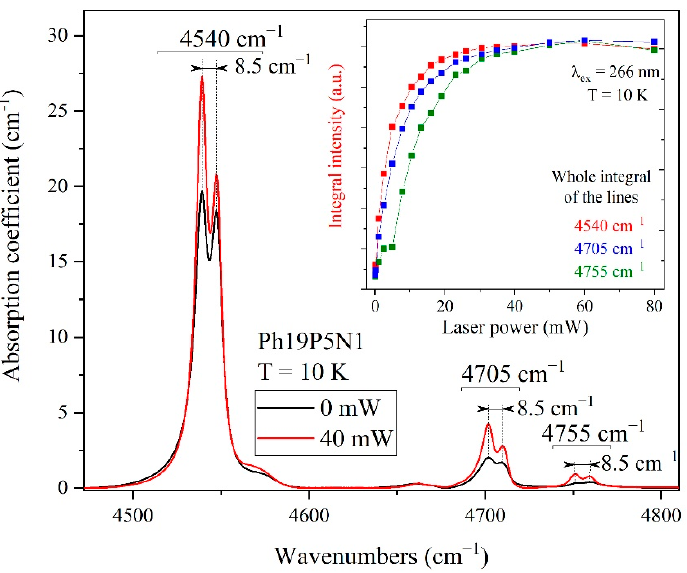
Figure 5. Absorption spectra of Ph19P5N1 sample in the region of phosphorus lines without (black) and with (red) laser irradiation with a wavelength of λ = 266 nm and a power of 40 mW. The inset shows the measured integral intensity of the doublet lines as a function of the laser radiation power.